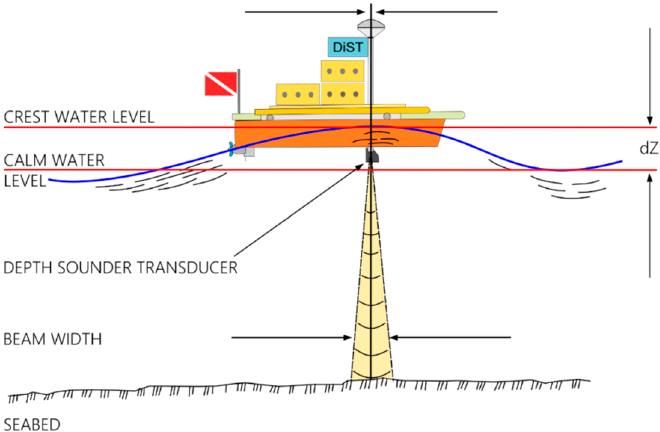
Figure 8. Vertical error in depth measuring due to the wave effect.